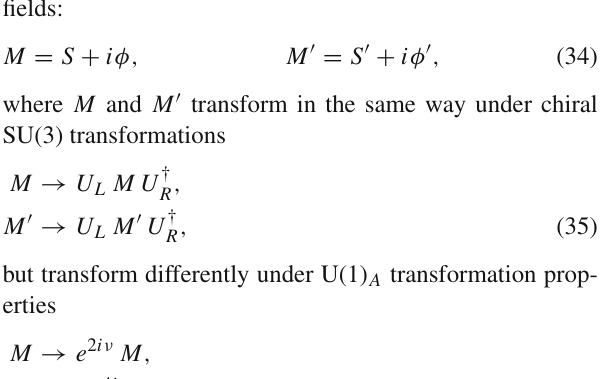
Table 1 The s-wave scattering lengths of I = 1, πη scattering in SNLSM (first row), GLSM (second row), O p 4 ChPT [147] (third row); nonlinear chiral Lagrangian of Ref. [138] (fourth row); non-relativistic effective field theory [156] (fifth row); estimates obtained at O p 4 in This work, SNLSM (Sect.